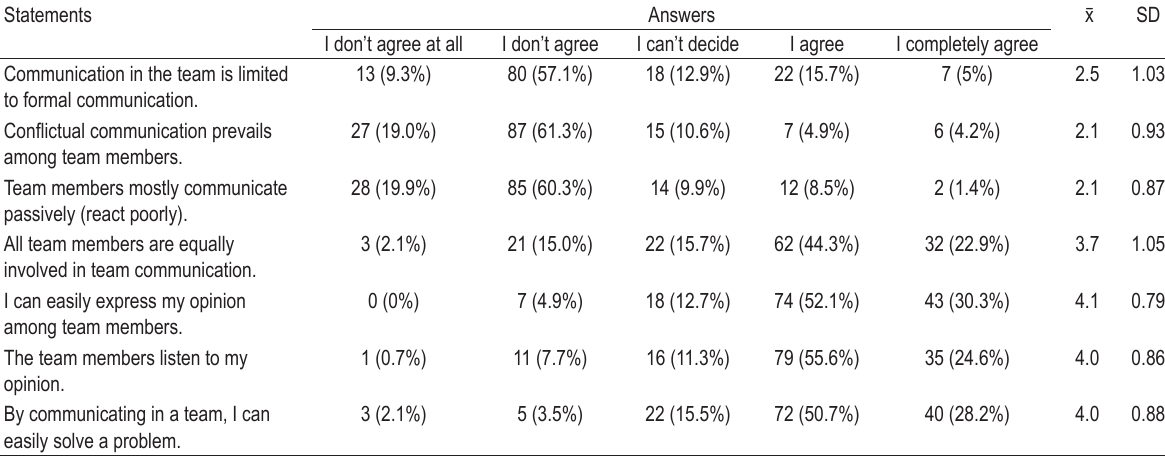
TABLE 3. Assessment of interprofessional team